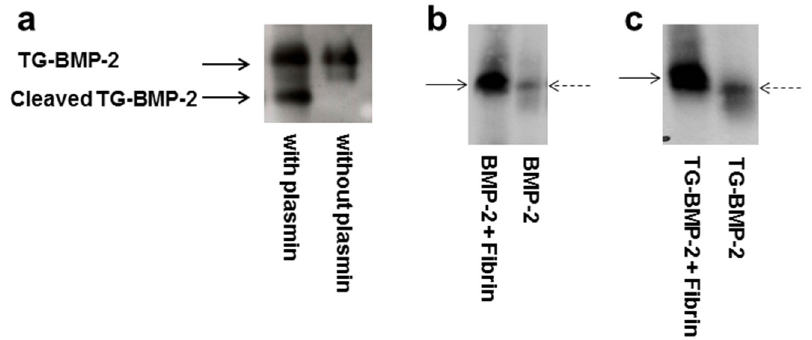
Figure 2. Functionality of plasmin and transglutaminase site. ( a ) Plasmin degradation of TG-BMP-2. TG-BMP-2 was incubated with plasmin or only buffer. Plasmin cleaves the TG-BMP-2. ( b ) and ( c ) Enzymatic digestion of growth factor alone and growth factor incorporated into a fibrin gel. ( b ) BMP-2 in fibrin digested by trypsin ( c ) TG-BMP-2 in fibrin digested by trypsin. Dashed arrow is the growth factor alone and solid arrow marks the fibrin material with the growth factor. The bands from the TG-BMP-2 incorporated into the fibrin have lower mobility than TG-BMP-2 alone, indicating that the TG-BMP-2 is covalently incorporated. In contrast, the BMP-2 has the same mobility alone as is incorporated into a fibrin